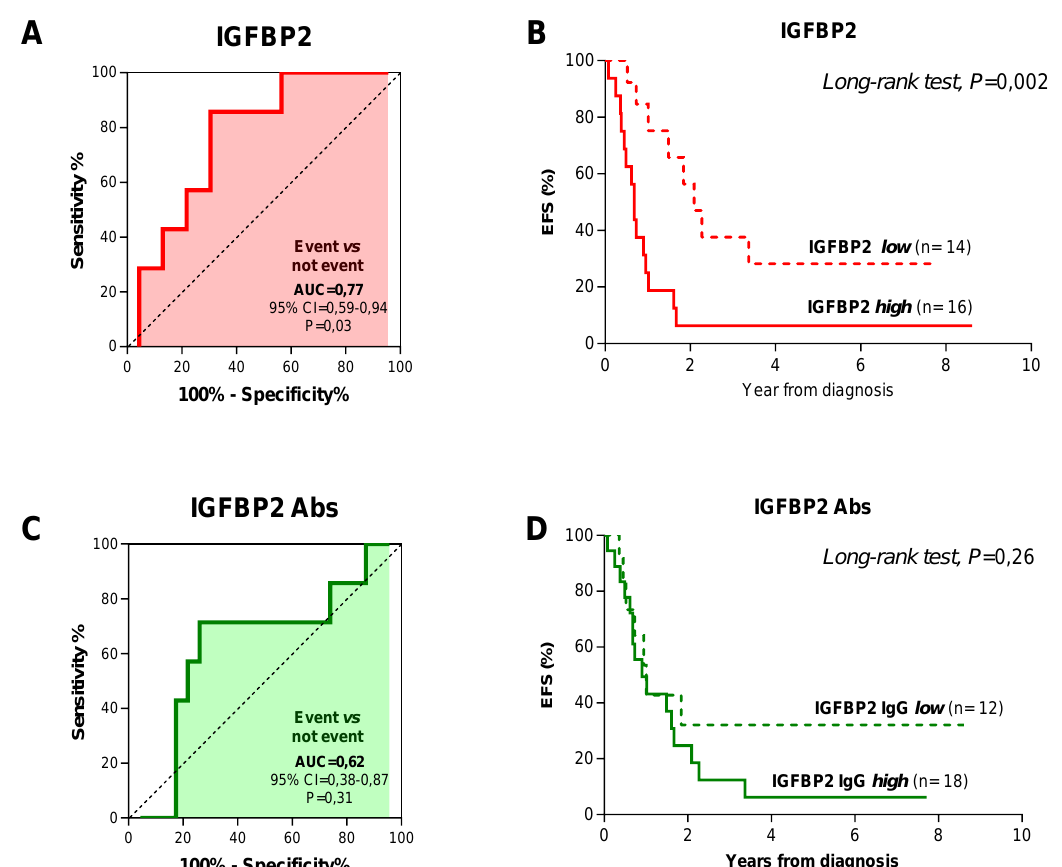
Figure 3. Event-free survival (EFS) analysis distinguishing metastatic RMS patients according to plasmatic IGFBP2 and anti-IGFBP2 autoantibodies levels. ( A ) ROC curve establishing the predictive value that discriminate patients experiencing an event or not based on IGFBP2 protein levels and ( B ) Kaplan-Meier survival analysis representing EFS of metastatic RMS patients distinguished according to IGFBP2 levels. ( C ) ROC curves using anti-IGFBP2 autoantibodies levels to discriminate patients as in ( A) and ( D ) Kaplan-Meier curves showing EFS of metastatic RMS patients distinguished according to anti-IGFBP2 levels. AUC, area under the curve; CI, confidence interval.